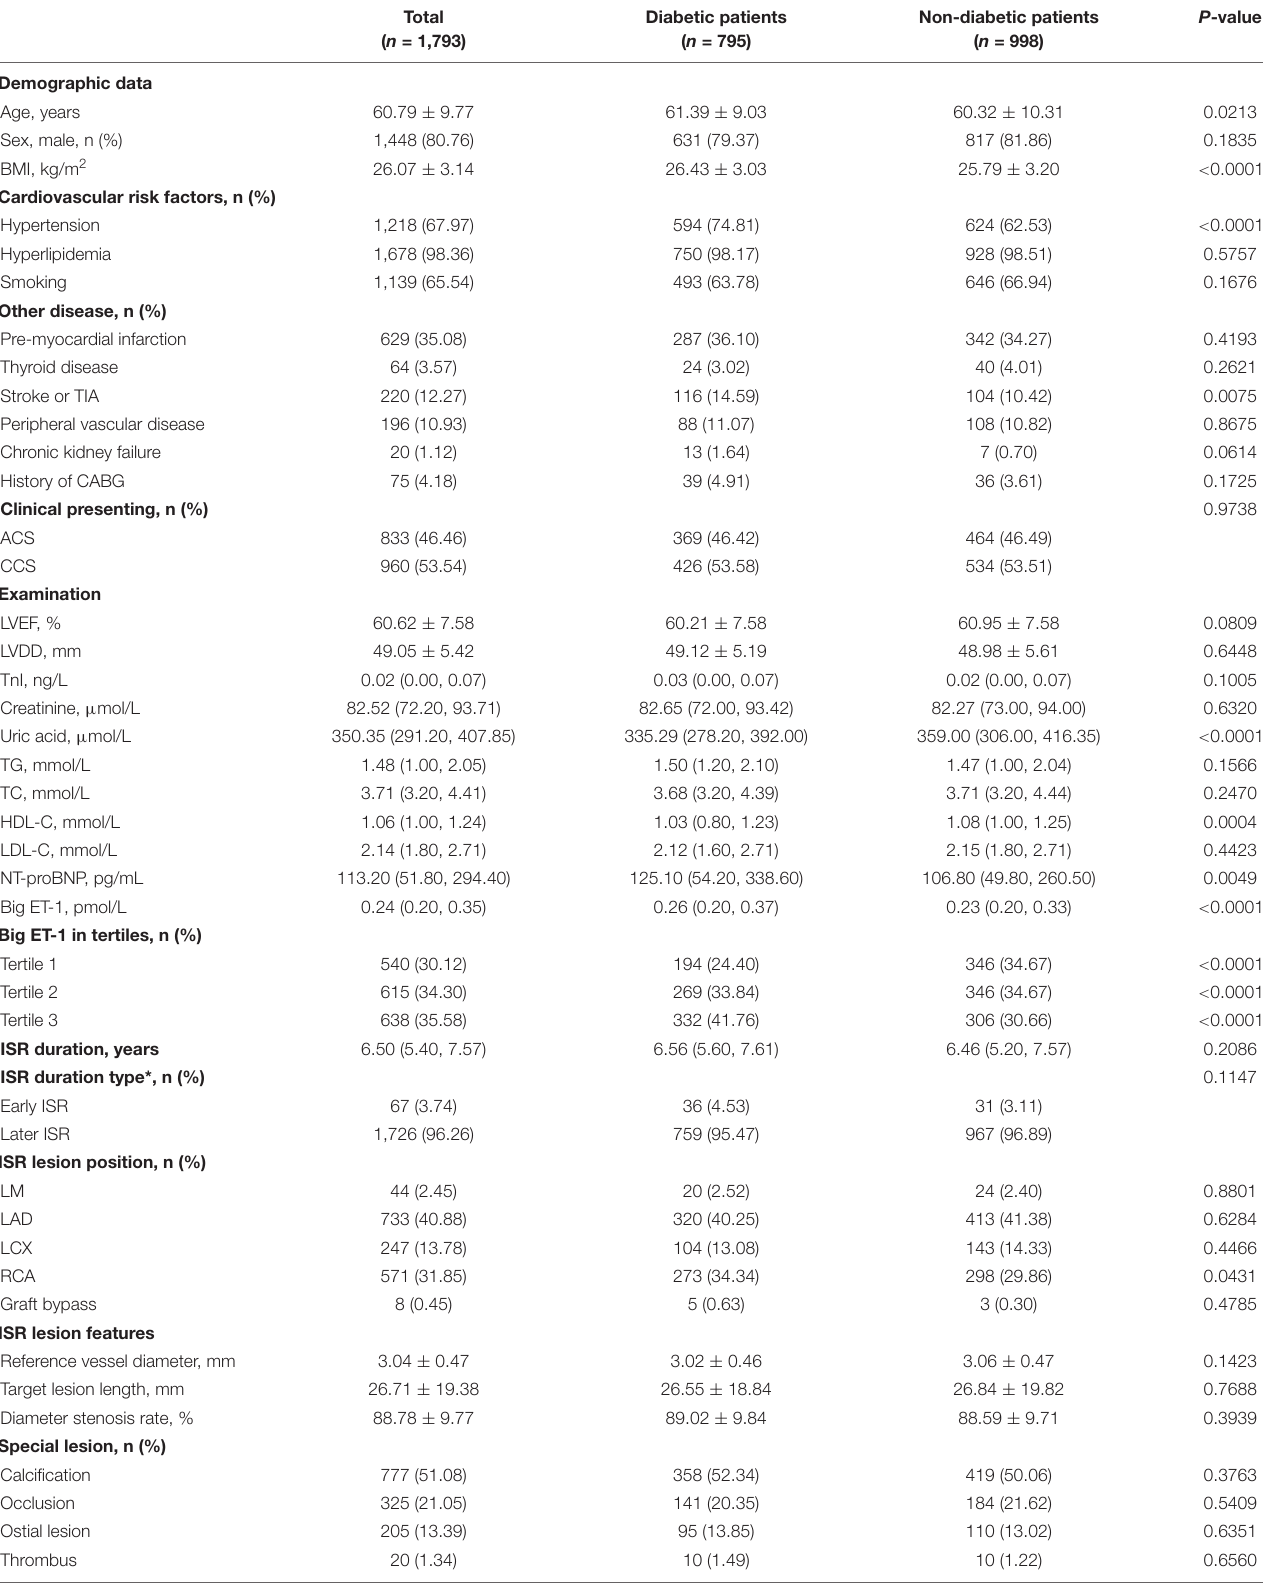
TABLE 1 | Baseline, lesion, and intervention characteristics of patients with coronary artery